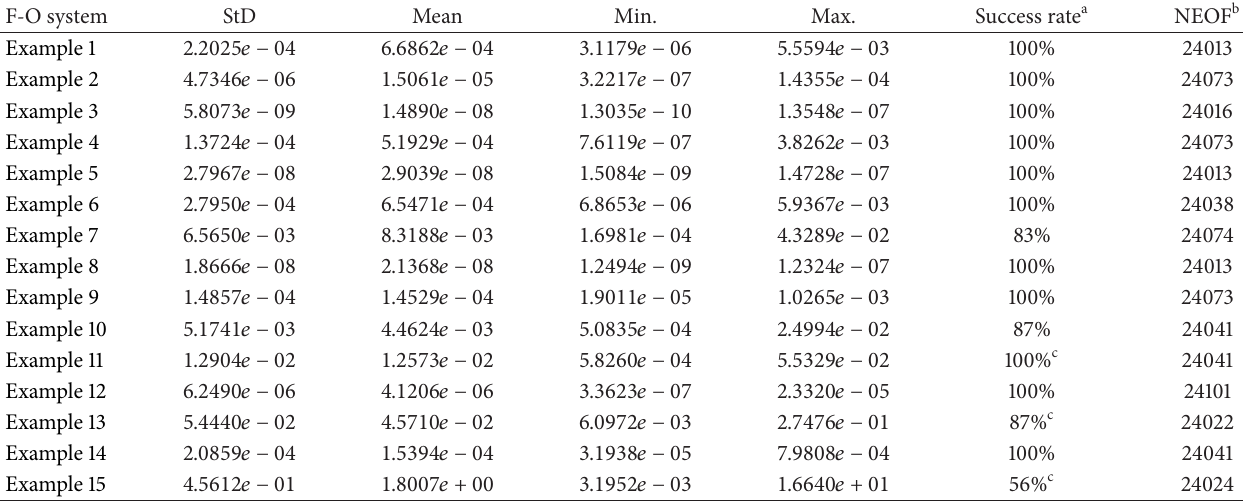
Table 2: Simulation results for different fractional-order chaos systems by CSODE.